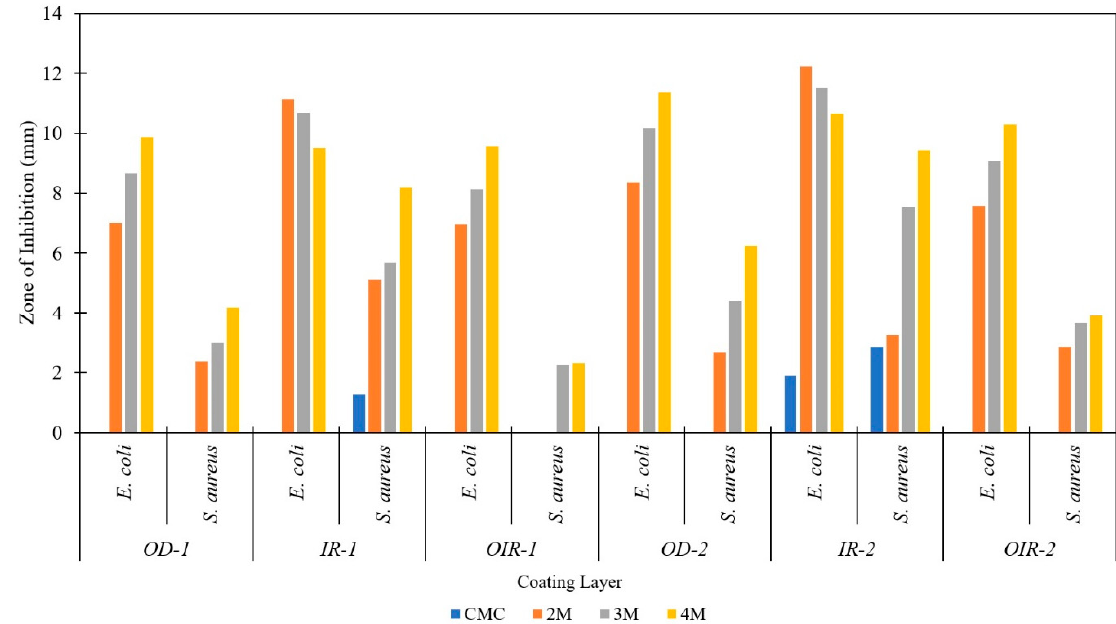
Figure 9. Antibacterial activity of fabricated cotton thread with different coating layers of CT/CMC cross-linked with different CA concentrations.